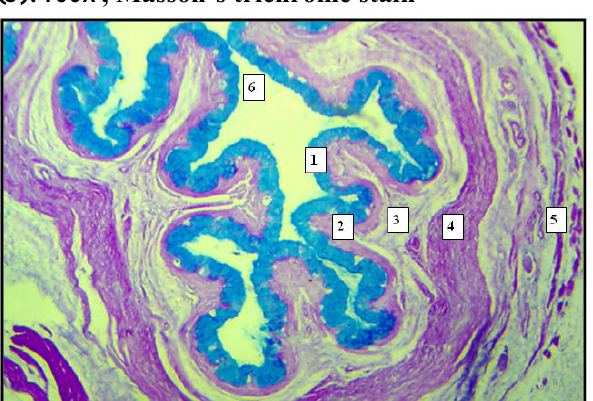
Figure 5. Vagina at fornix region showed folded mucosa lined with simple columnar mucous epithelium stained positively with Alcian blue stain (1), propria-submucosa (2& 3), internal layer of tunica muscularis (4), external layer of tunica muscularis (5), vaginal lumen (6). 40X, Alcian